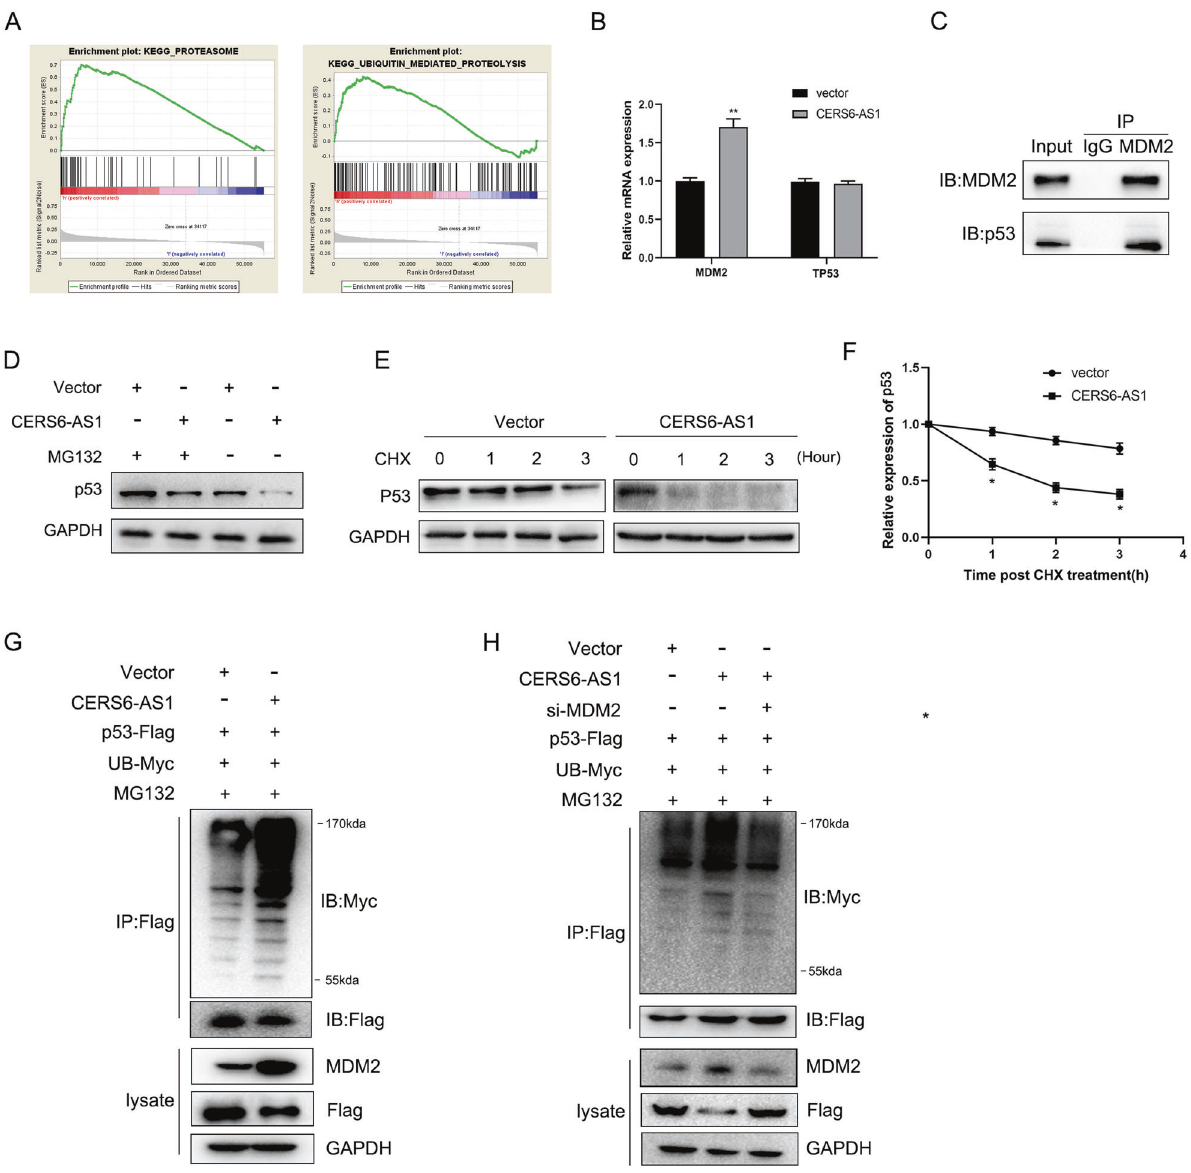
Fig. 7 LncRNA CERS6-AS1 upregulates MDM2 and promotes MDM2-mediated ubiquitin-dependent degradation of p53. A GSEA analysis indicated that CERS6-AS1 was signi fi cantly correlated with proteasome and ubiquitin-mediated proteolysis. B qRT-PCR analysis was performed to evaluate the expression of MDM2 and TP53 in CERS6-AS1 overexpression group. C The interaction between MDM2 and p53 was veri fi ed by co-immunoprecipitation assay. D The protein stability of p53 were evaluated in Vector group and CERS6-AS1 overexpression group with the treatment of MG132 (4 h, 5 μ M) in HepG2. E The protein levels change of p53 in CERS6-AS1 overexpression and control groups when HepG2 cells were treated with cycloheximide (CHX, 50 μ g/ml) for 0 – 3 h, respectively. F The curve of CHX treatment showed the change of MDM2 protein expression. G The ubiquitination levels of p53 in CERS6-AS1 overexpression and control groups. H Silence MDM2 partly reverse the promoting effect of CERS6-AS1 overexpression on p53